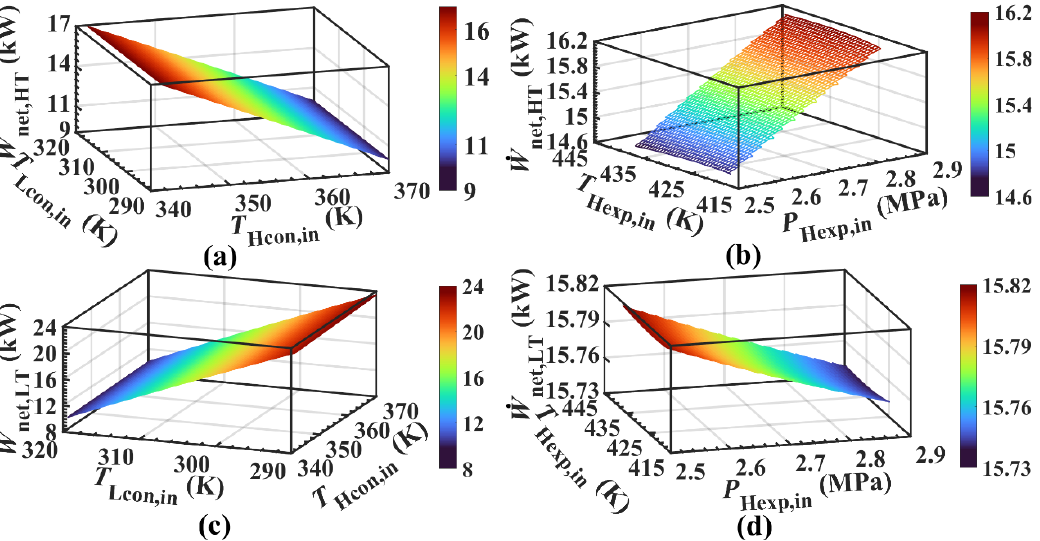
Figure 6. Influence characteristics of key variables on power in HT cycle and LT cycle. (a) Influ- ence characteristics of different loop condenser inlet temperatures on HT cycle power. (b) Impact characteristics inlet temperature and the pressure of the expander on the power in the HT cycle. (c) Effect characteristics of different loop condenser inlet temperatures on LT cycle power. (d) Ef- fect of expander parameters of the HT cycle on the power of the LT cycle.